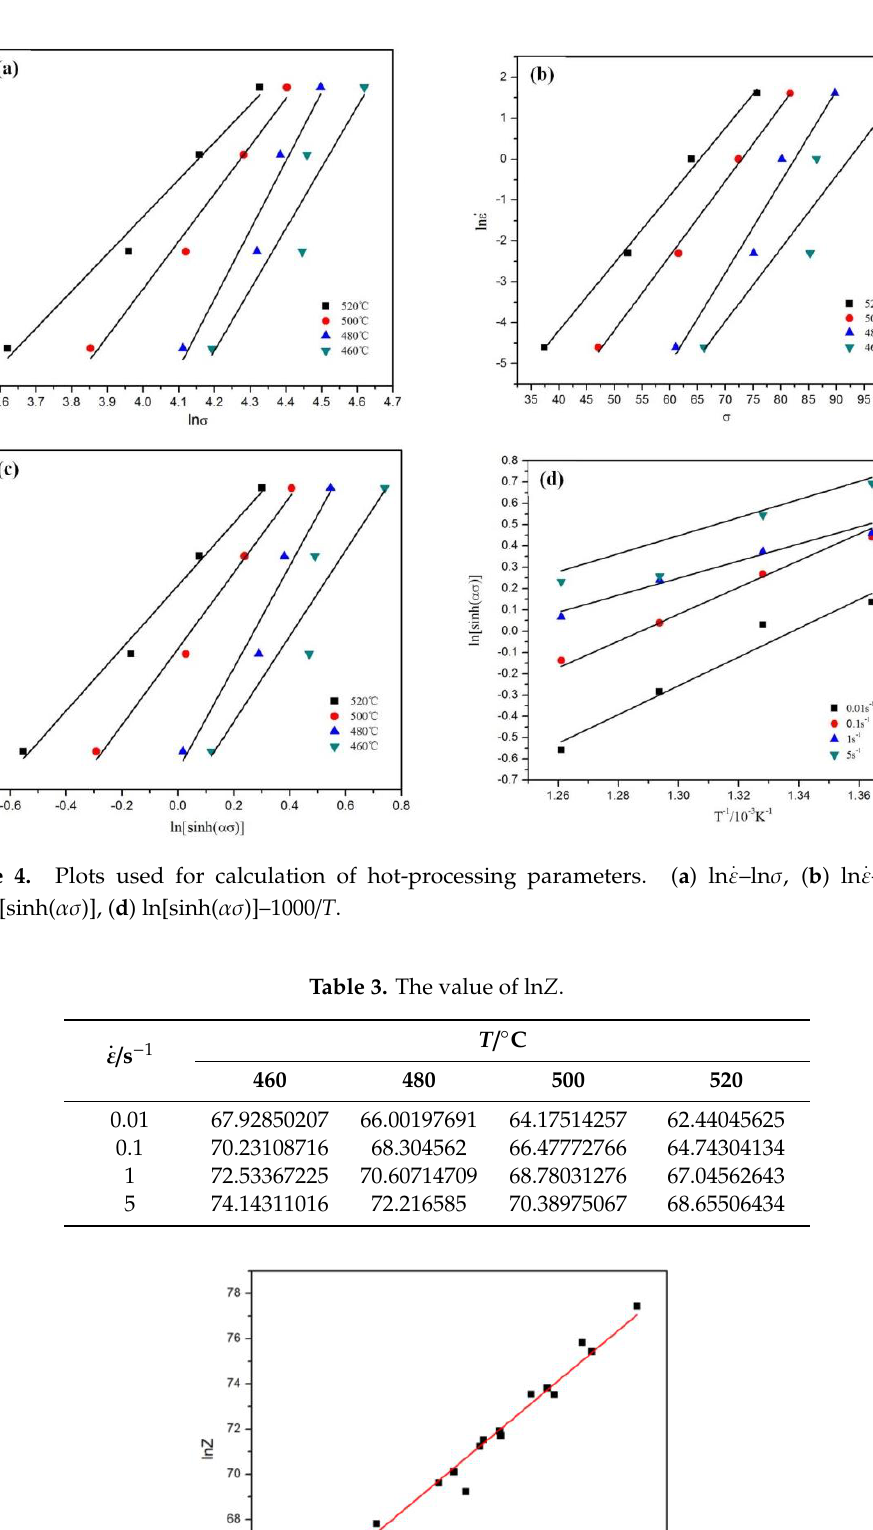
Figure 5. Plots used to derive the constitutive equations.